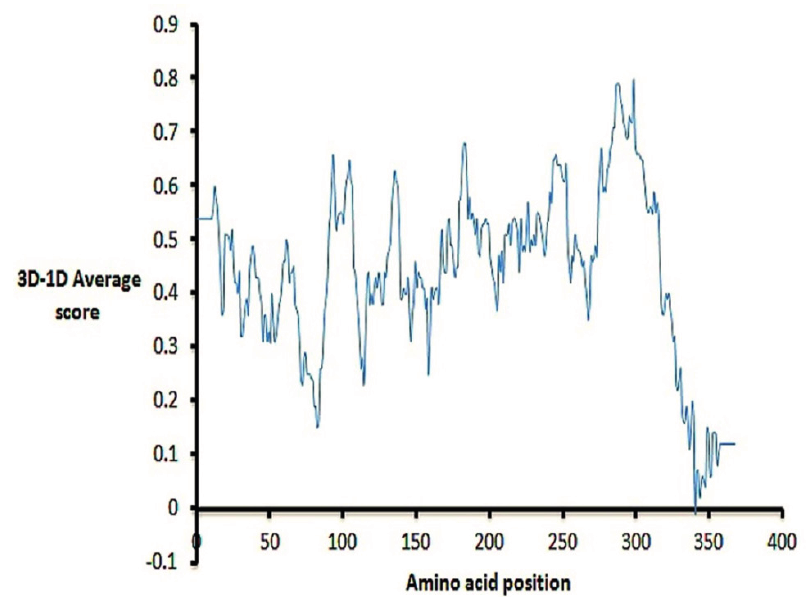
Figure 3. Verify3D plot of the Plasmodium falciparum histone deacetylase1 Pf HDAC1 homology